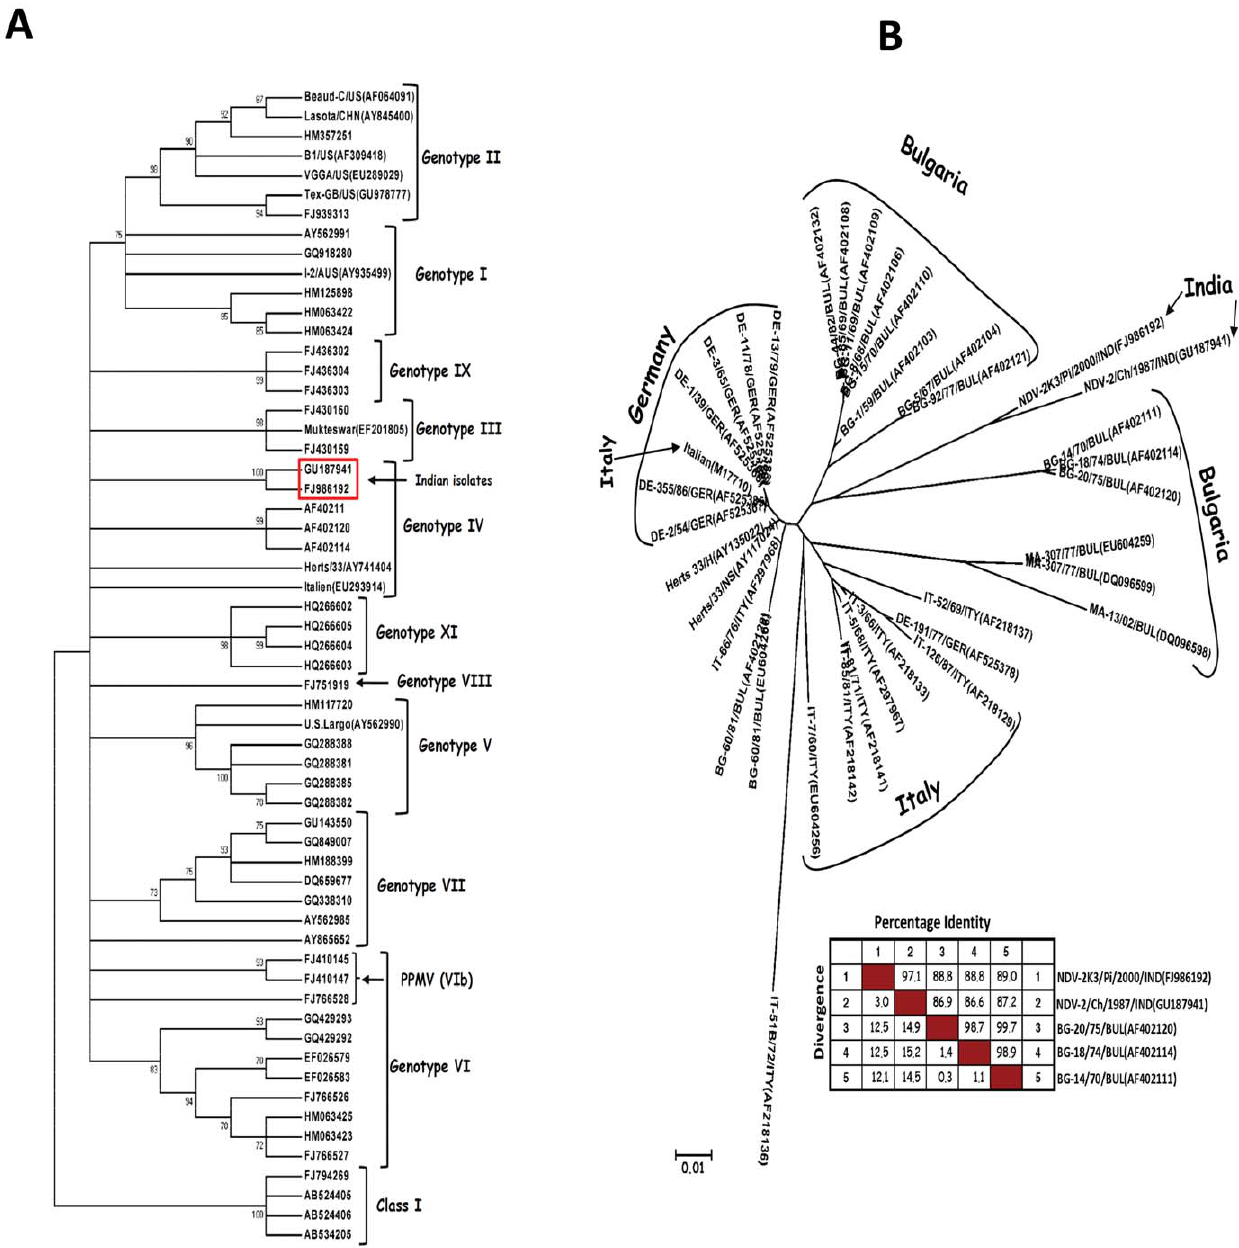
Figure 1. Phylogenetic relationship of Pigeon isolate NDV-2K3/Pi/2000/IND (FJ986192) and Chicken isolate NDV2/Ch/1987/IND (GU187941) from Tamil Nadu, India based on the 374-nucleotide sequence of the Fusion protein gene. A: A rooted consensus tree drawn to scale with 70% cut off value was obtained with the evolutionary history inferred by using the Maximum Likelihood method based a discrete gamma distribution model with evolutionary rate differences among sites, that also allowed some sites to be evolutionarily invariable (GTR + G + I) using MEGA5. Note : The NDV-2K3 (FJ986192) and NDV-2 (GU18794) from India (boxed) groups itself with Herts’33 (AY741404), Italian (EU293914) and other Bulgarian isolates in Genotype IV. The Class I APMV viruses (FJ794269, AB524405, AB524406 & AB534205) remain as an outgroup. B: An unrooted tree to show the relationship of 374 bp fusion protein gene of NDV-2K3 (FJ986192) and NDV-2 (GU187941) from Tamil Nadu, India with the other reported Genotype IV NDV strains from GenBank. Note : NDV-2K3 and NDV-2 from India groups with the Bulgarian genotype IV isolates (AF402111, AF402114 and AF402120). The percentage identity and divergence of the Indian isolates with these Bulgarian isolates are shown in the insert.